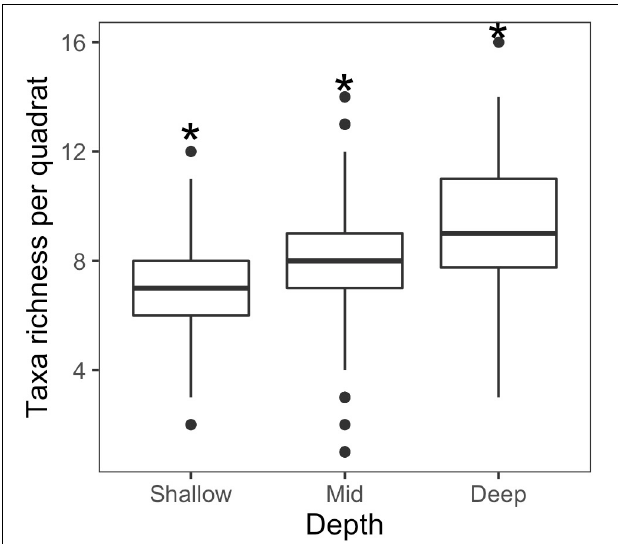
FIGURE 4 | Boxplot of species richness among shallow, mid, and deep reefs. The * indicates p < 0.001 obtained by randomization test.